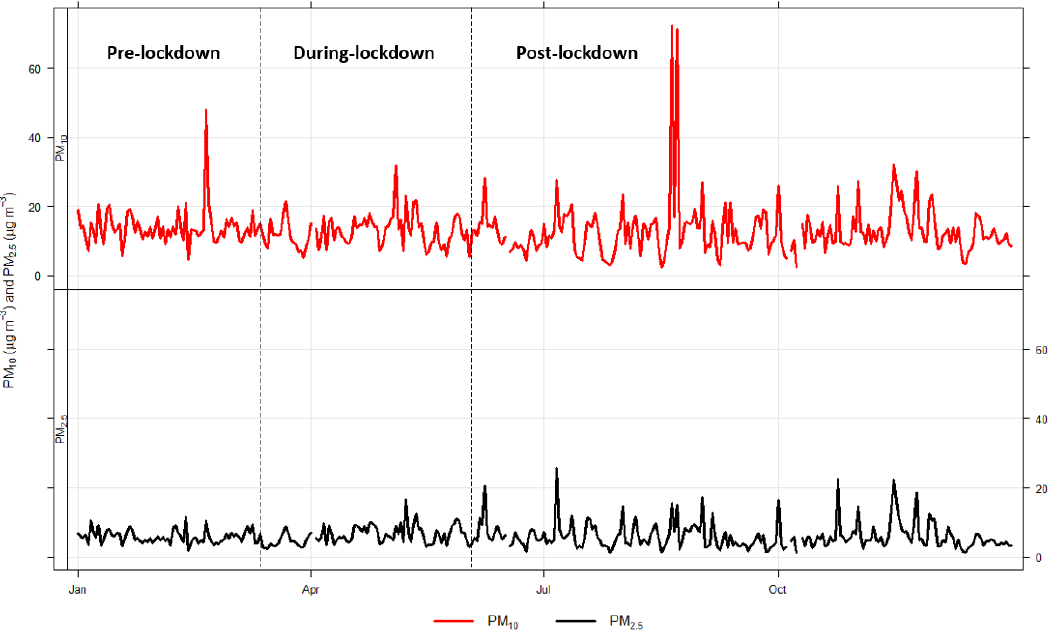
Figure 4. The variation in 24 h PM 10 and PM 2.5 concentrations at Rocklea monitoring station for different periods.